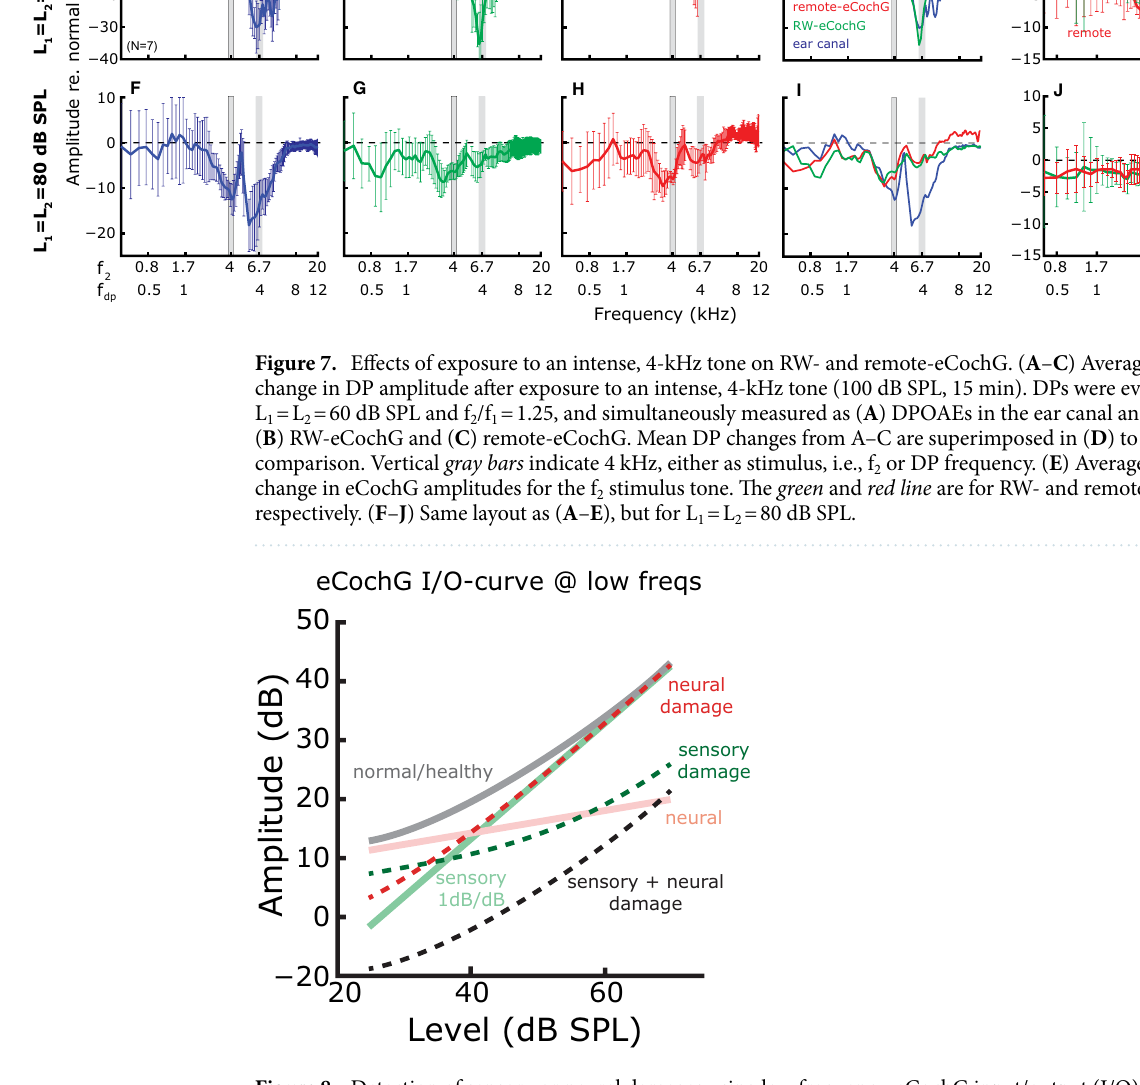
Figure 8. Detection of sensory or neural damages using low frequency, eCochG input/output (I/O) curves. The eCochG I/O curve ( gray ) is composed of linear sensory ( solid green , 1 dB/dB) and compressive nonlinear neural component ( solid pink , < 1 dB/dB). Damage to the sensory and/or neural component results in different changes of the I/O-curves ( dashed lines ), providing a means to identify different types of hearing